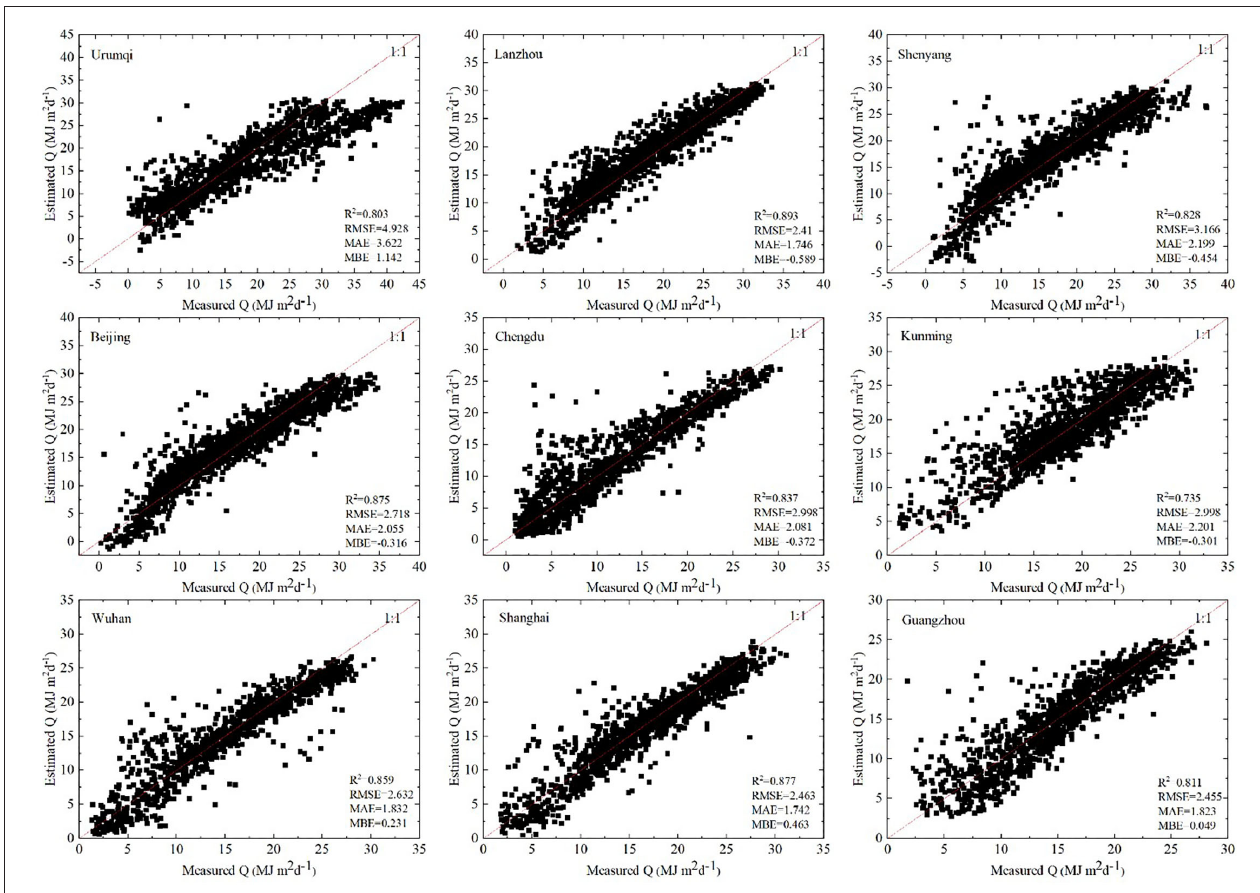
FIGURE 6 | Scatter plot of predicted values and measured values of